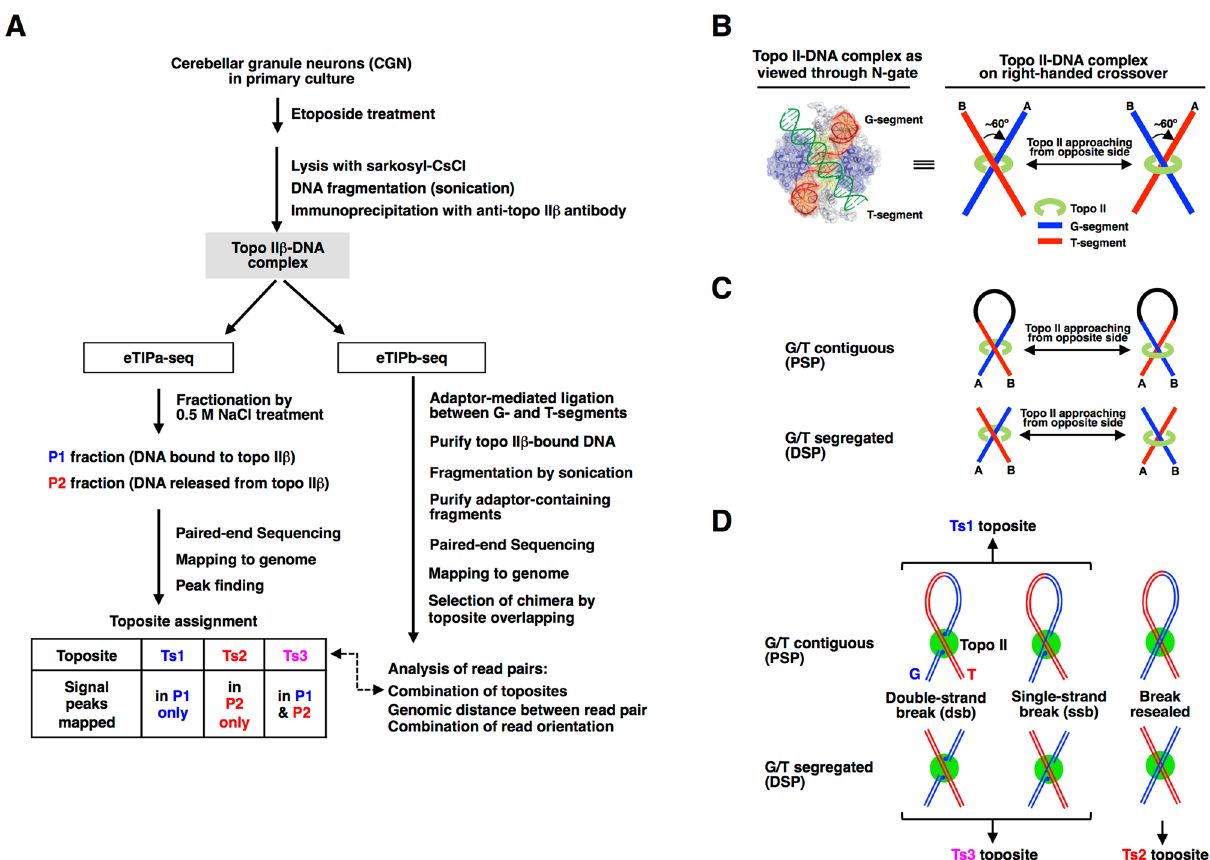
Figure 1. Overview of the eTIP-seq, a mapping technique used in the study and three rules for topo II-DNA interactions that provide the method’s logical basis. ( A ) A flow diagram of eTIP-seq. The topo IIβ-DNA complex in the shaded box was isolated by a procedure similar to eTIP as described previously 11 (illustrated in Supplementary Fig. S1). DNA in the complex captured on magnetic beads was processed in either way: fractionation by 0.5 M NaCl treatment (eTIPa-seq) or adaptor-mediated ligation (eTIPb-seq). In eTIPa-seq, P1/P2 DNA fractions were analyzed by sequencing and mapped on rat genome. The signal peaks were used to classify the topo IIβ action sites into 3 categories. Experimental results, data processing and toposite assignments for eTIPa-seq are summarized also in Supplementary Fig. S1. The eTIPb-seq procedure is illustrated in detail in Fig. 3A. ( B ) Rule #1. Topo II acts on right-handed DNA crossovers from alternate direction, which selects different duplex as G-segment. The enzyme–DNA configuration depicted in the center is equivalent to the crystallographic representation shown on the left 16 . The two DNA segments at the crossover point are discriminated by ‘A’ and ‘B’. ( C ) Rule #2. G- and T-segments are either contiguous or segregated. As cellular DNA is sheared by sonication before immunoprecipitation, G- and T-segments can reside on different DNA fragments. If the crossover point locates within the same fragment, however, these segments associated with topo II enzyme are contiguous to form a loop. ( D ) Rule #3. The topo IIβ-DNA complex formed under the conditions used for eTIP-seq are constituted of 3 species. Relationships between the cleaved forms and toposites are also indicated in the tions of toposites are listed in Supplementary Table S1 and Ts2/Ts3 clusters in Supplementary Table S2. Relative numbers of toposites differ significantly, Ts1 being most prominent (Supplementary Fig. S1). GC contents of toposites are consistent with the above observation. Ts1 sites are significantly GC-rich as compared to Ts2/Ts3 sites (Fig. 2B). To investigate functional relevance, locations of these toposites were then looked at with respect to characteristic regions: transcription start site (TSS zone), genic region (GR), and inter- genic region (IR) (Fig. 2C). Only protein-coding genes are taken into account using the “exRefSeq” which is derived from the rat reference sequence 11 . TSS zone (± 2 kb region encompassing the transcription start site) was included in the analysis as a functional region associated with genes. TSS zone normally overlaps with transcrip- tion control region containing promoter and binding sites for transcription factors. Ts1 was highly concentrated in gene-associated regions especially in the TSS zone. In contrast, Ts2/Ts3 sites, as viewed from the number of clusters, were enriched in intergenic regions. SP120 (hnRNP U/SAF-A/SP120) is a multifunctional nuclear protein that binds both RNA and DNA 18–21 . A recent report shows that the protein binds chromatin-associated RNA and is involved in the organization of chromatin structure in a transcription-dependent manner 22 . Our previous study demonstrated that SP120 is a partner protein of topo IIβ that activates and stabilizes the enzyme through RNA-dependent association 23 . We